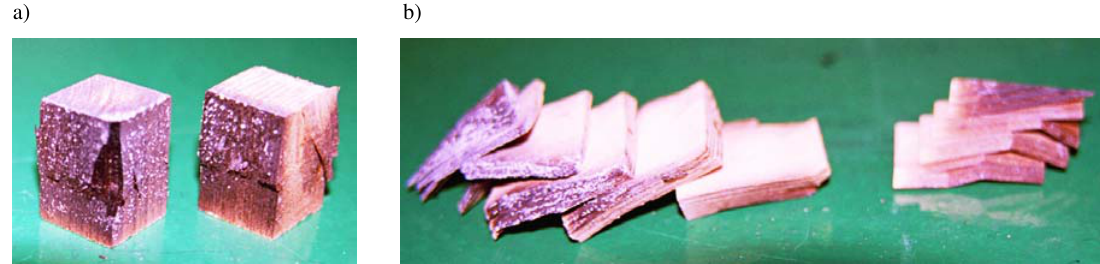
Fig 14. Damage character for impregnated samples after compressive strength tests above 200